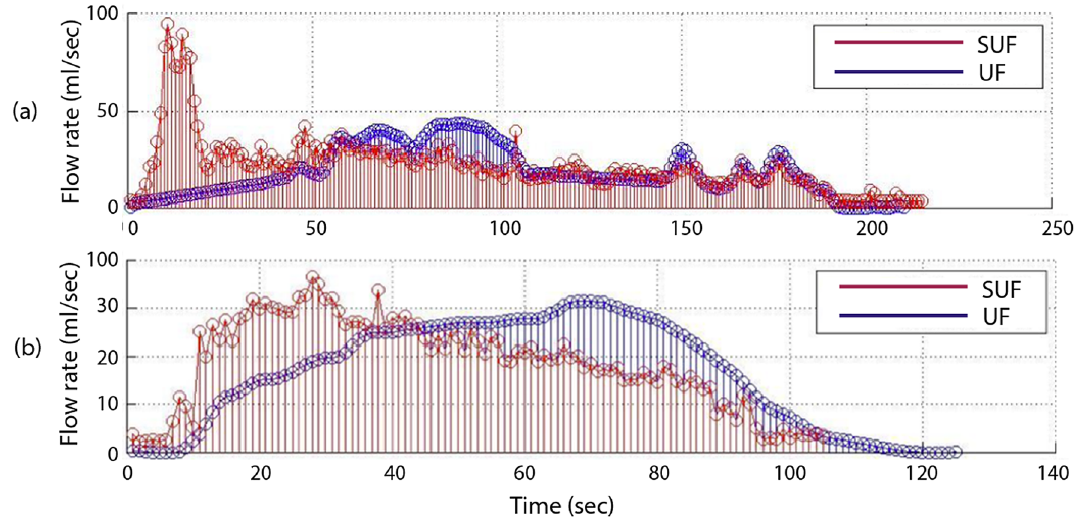
Figure 4. Cases with large non-overlaps between the UF and SUF flow rate curves. UF uroflowmetry, SUF sonouroflowmetry.